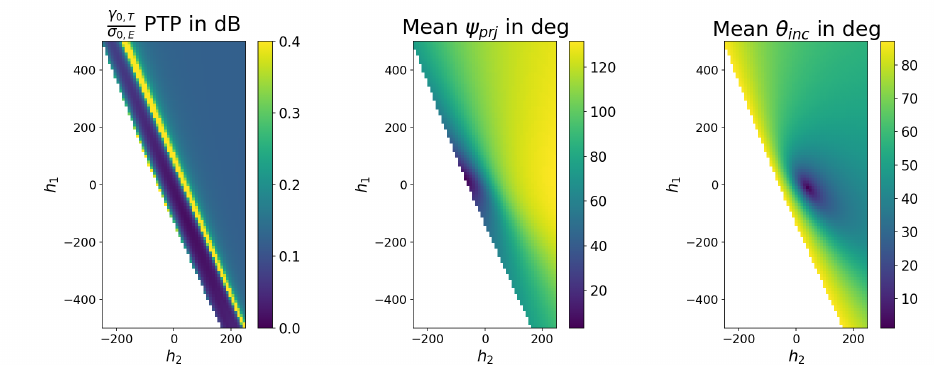
Figure 4. Scatter plots of ( Left ) along-track baseline ( B ref v ) in meters vs. perpendicular baseline ( B ref in meters and ( Right ) parallel baseline ( B ref ) in meters vs. perpendicular baseline ( B ref ⊥ ) in meters (cid:107) corresponding to ALOS-1 stack w.r.t the imaging geometry of 2006-06-30 acquisition for h 1 = 0 and h 2 = 0.